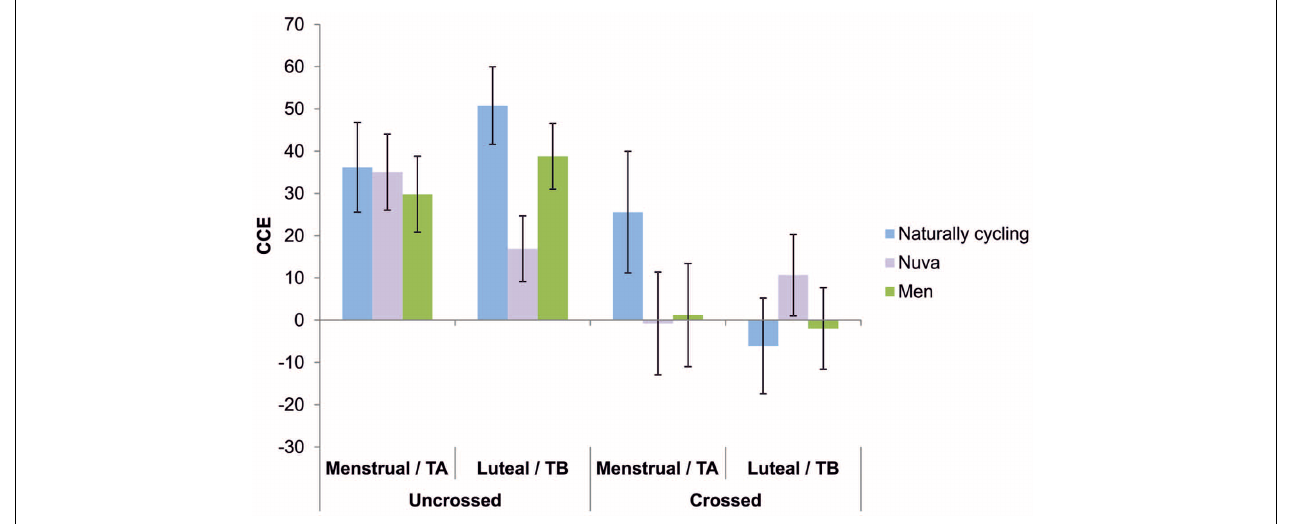
FIGURE 3 | CCEs for naturally cycling women (blue bars), women using hormonal contraceptives (purple bars), and men (green bars) during the menstrual(M)andlutealphase(L)anddifferenttestsessions(TAandTB),respectively. CCEsareshownforcrossedanduncrossedhandpostureconditions.